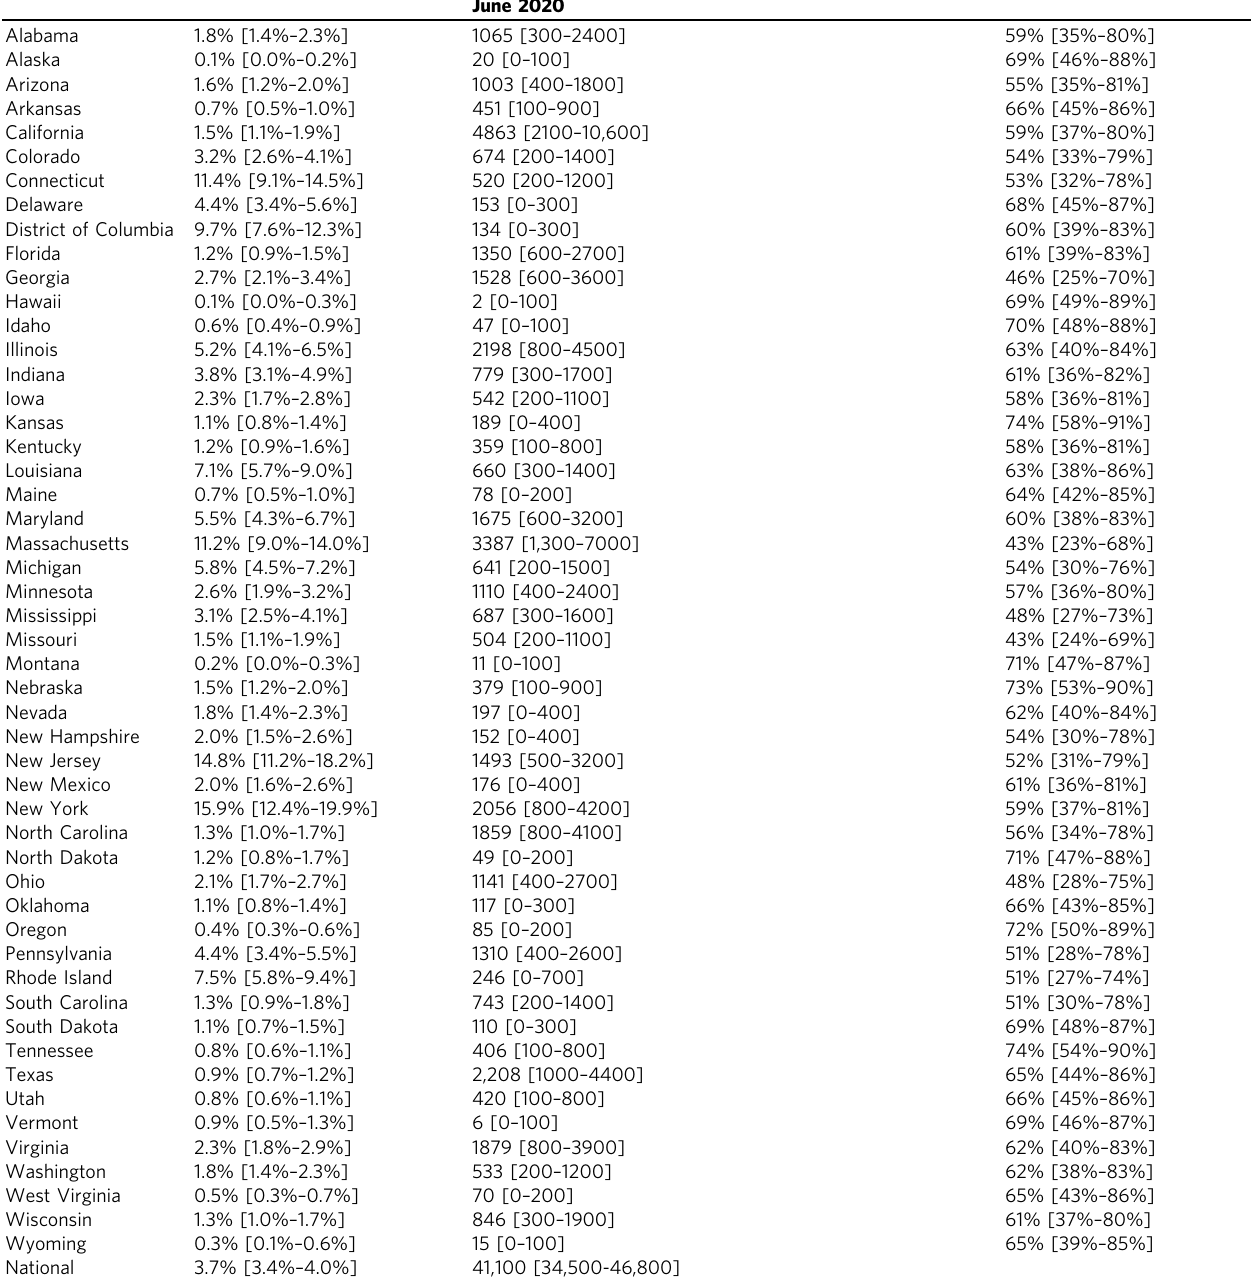
Table 1 Posterior model estimates of percentage of total population ever infected, mean new infections per day over week ending 01 June 2020, and infection ascertainment ratio as of 01 June 2020. We present the mean and the 95% credible intervals in square